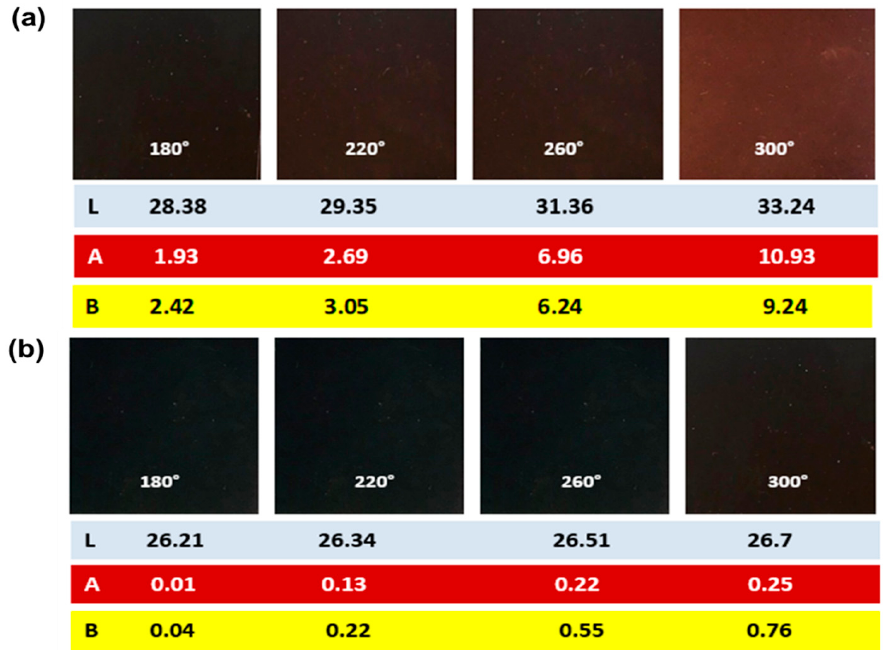
Figure 3. Photograph of painted panels depicting colorimetric measurements (L, A, B) of calcined: ( a ) bare Fe 3 O 4 ; and ( b ) SHMP-treated Fe 3 O 4 with 30 min of in situ heat exposure in an alkyd coating system.